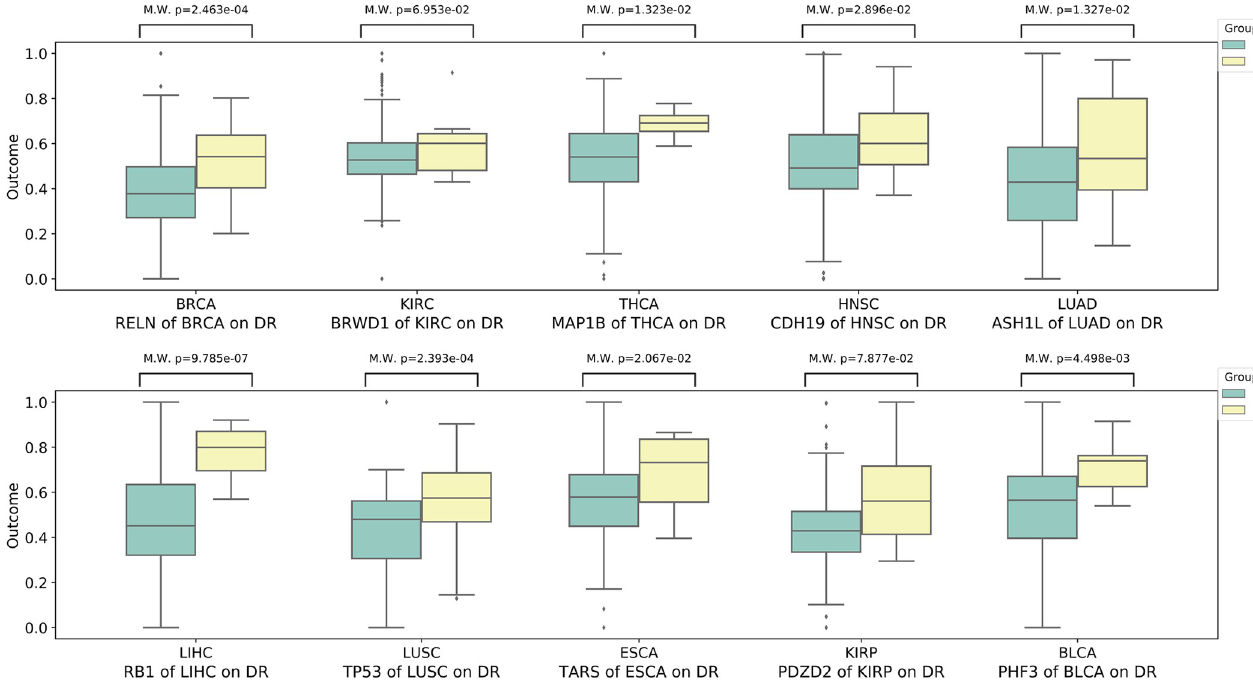
Fig 5. The Mann-Whitney U test (M.W.) analysis reflects the significant differences between mutated groups and non-mutated groups of mutated genes with high ATE values in the activity of DNA replication (DR) for 10 cancers.